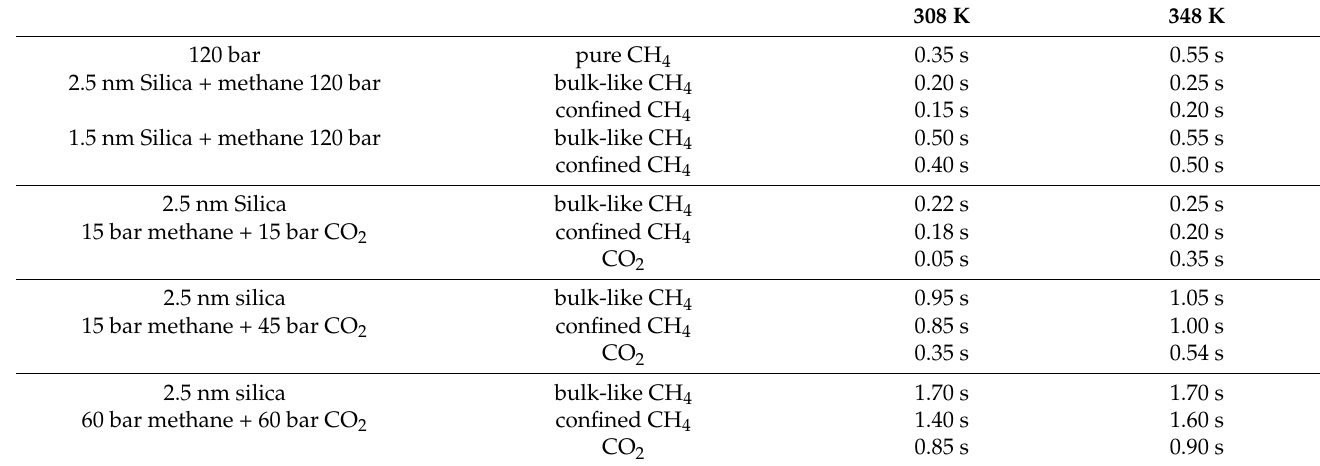
Table 4. T 1 relaxation values of methane for the bulk, bulk-like and confined states and in the presence of CO 2